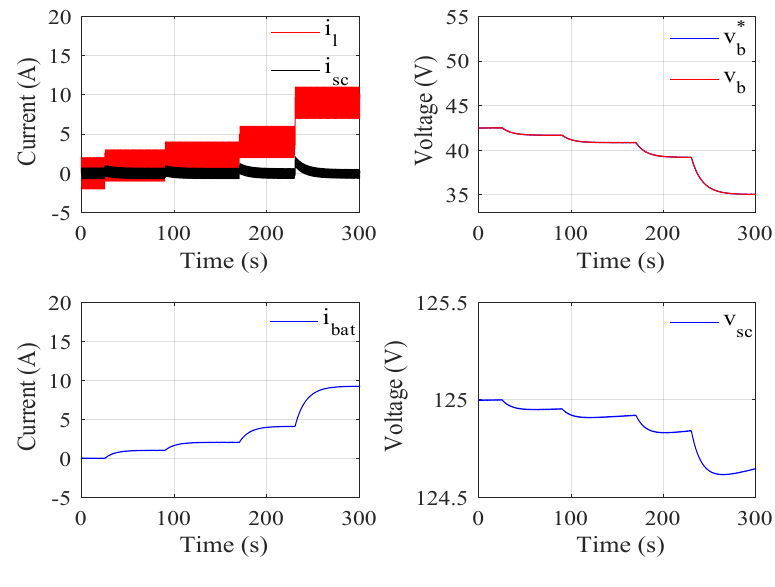
Figure 11. Simulation results: 30% SOC.